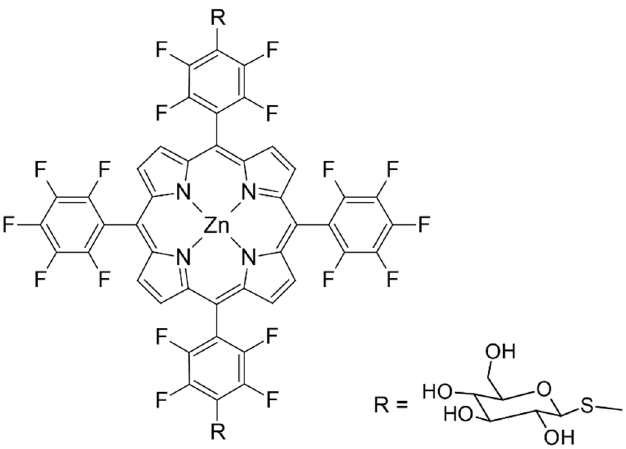
Figure 7. 62 Zn fluorinated porphyrin conjugated to S-glycosylated groups. Adopted from [56]. Manganese porphyrins are used as paramagnetic contrast agents, with low toxicity, high electronic spins, a fast water exchange rate, and high complex stability [93–95]. The most extensively investigated, Mn(III) tetraphenyl porphyrin sulfonate (MnTPPS 4 ), exhib- ited no demetallation in vitro in human plasma for up to 9 days and only about 1% degree of demetallation in vivo in the liver and kidney up to 4 days post administration